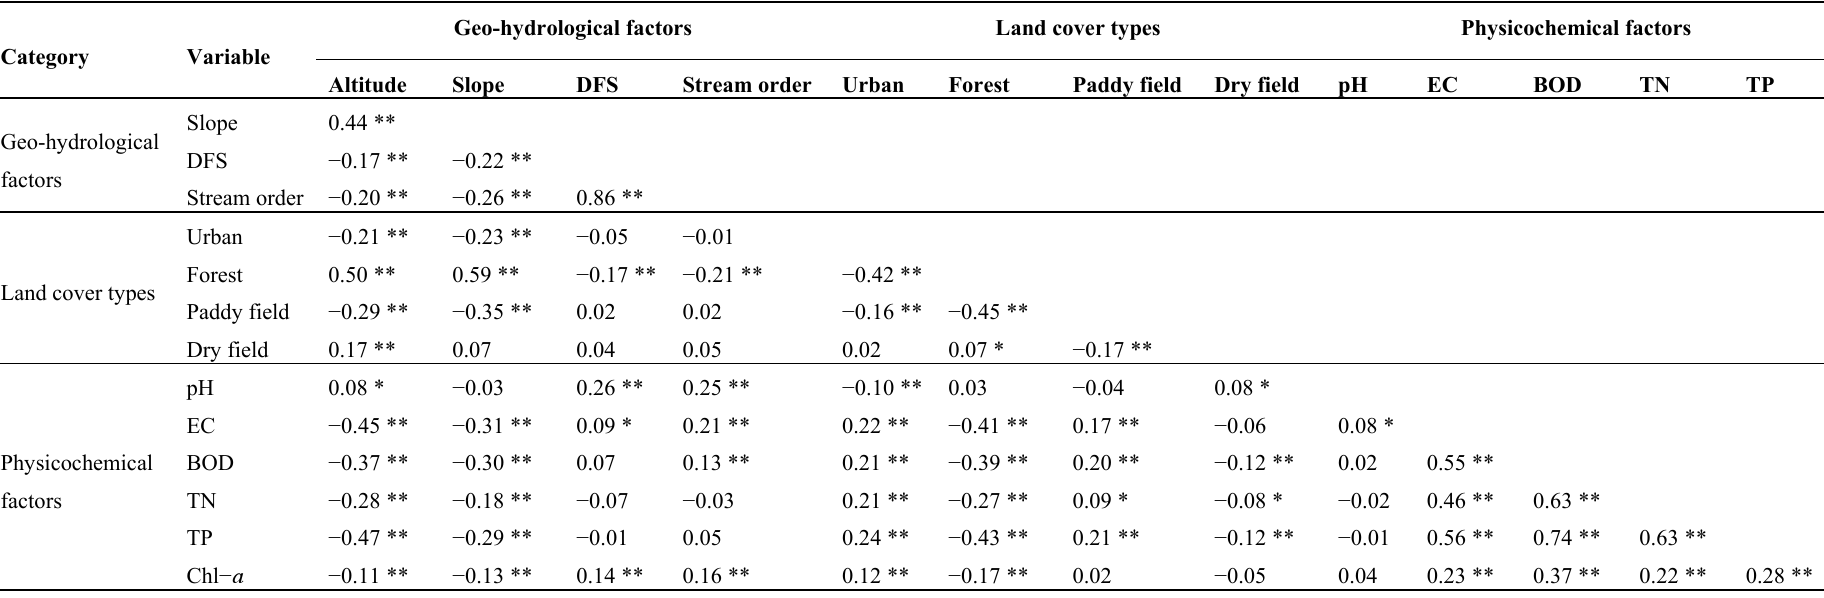
Table 3. Spearman rank correlation coefficients between 14 environmental factors (* P < 0.05, ** P <